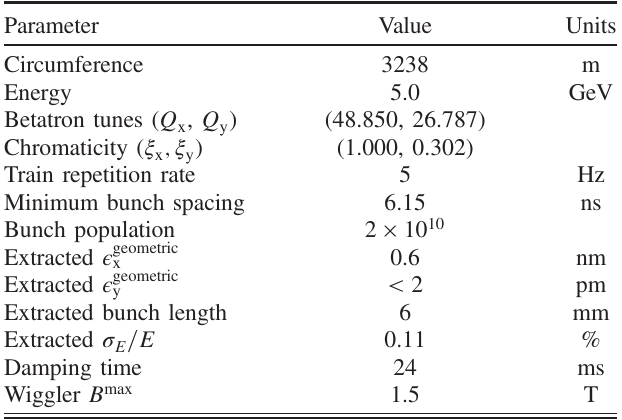
TABLE I. Summary of the DTC04 lattice parameters. Parameter